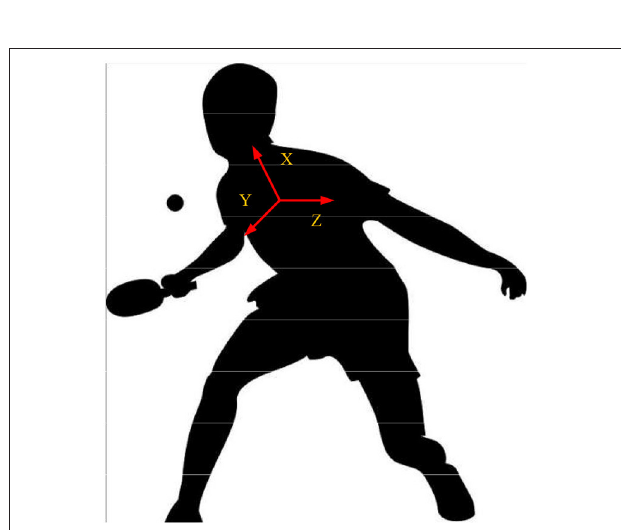
FIGURE 4 | Axis points of human